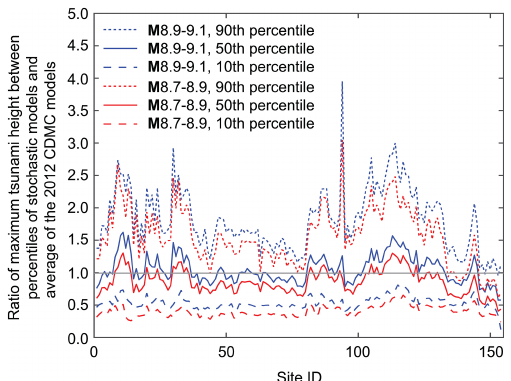
Figure 7. Ratio of maximum tsunami heights between three per- centiles of the stochastic source models and the average of the 11 CDMC models along the coast of Kochi and Tokushima pre- fectures for the two magnitude ranges M 8.9–9.1 and M